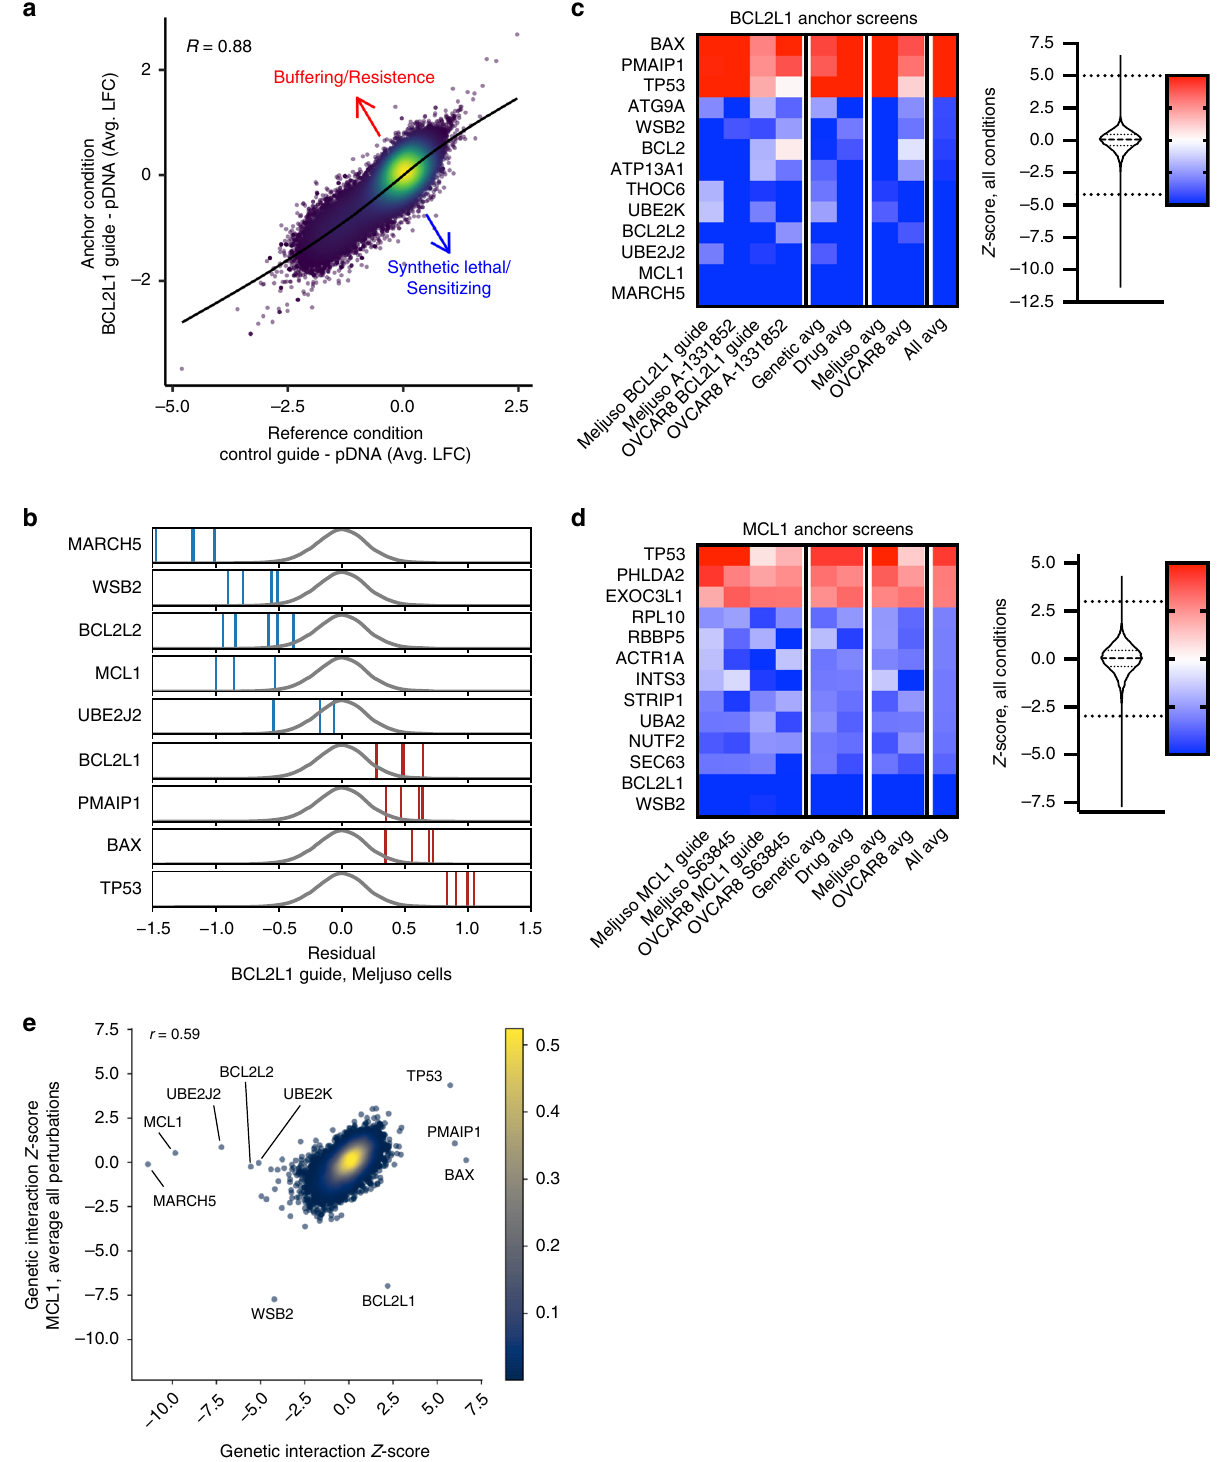
Fig. 2 Anchor screens of BCL2L1 and MCL1 recover known and novel interactions. a Average log2-fold changes for guides in Meljuso cells for control and BCL2L1 knockout lines. Points are colored by density. Pearson correlation coef fi cient is indicated. b Residuals for guides from the BCL2L1 anchor screen in Meljuso. Blue and red lines correspond to lethal and buffering guides respectively. Density of all guides is indicated by the gray distribution. c Top 13 hits ranked by absolute average Z -score across all BCL2L1 screens. Color scale of Z -scores is shown to the right. A violin plot representing the distribution of Z -scores is adjacent to the color scale, along with two dotted lines representing the cutoffs for gene hits shown. The color scale is fl oored at − 5 and ceilinged at 5. d Top 13 hits ranked by absolute average Z -score across all MCL1 screens, as in c . e Comparison of average Z -scores for all MCL1 and BCL2L1 perturbations screened with the Brunello library. Genes with an absolute average Z -score greater than 5 in either condition are